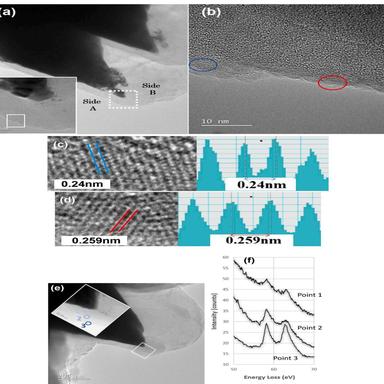
(a) Low magnification TEM image of the deposited Li-C on AuNPs, (b) magnified TEM image of the rectangular area in the inset in (a). (c, d) Lattice images of the blue and red circles in (b) with intensity profiles corresponding to metallic Li (110) and Li2O (111), respectively. (e) Bright-field scanning transmission electron microscope (STEM) image illustrating the spots for EELS analysis, and (f) results of the EELS analysis at the respective spots. (For interpretation of the references to colour in this f